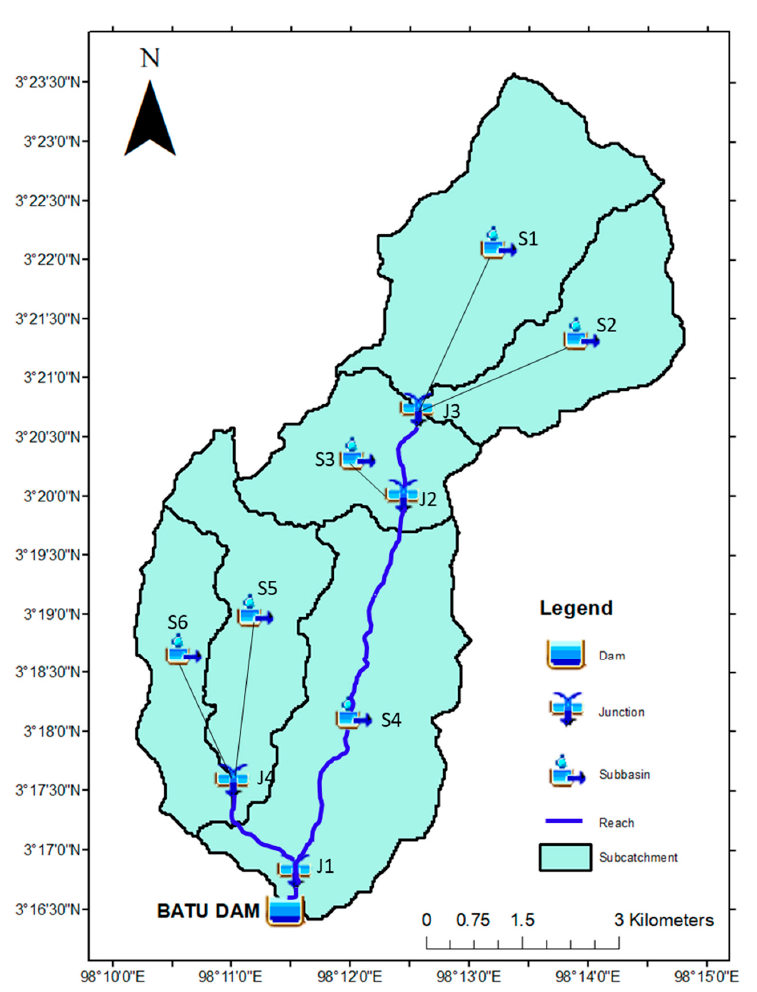
Figure 6. Basin Model Setup for Batu Dam Scheme.